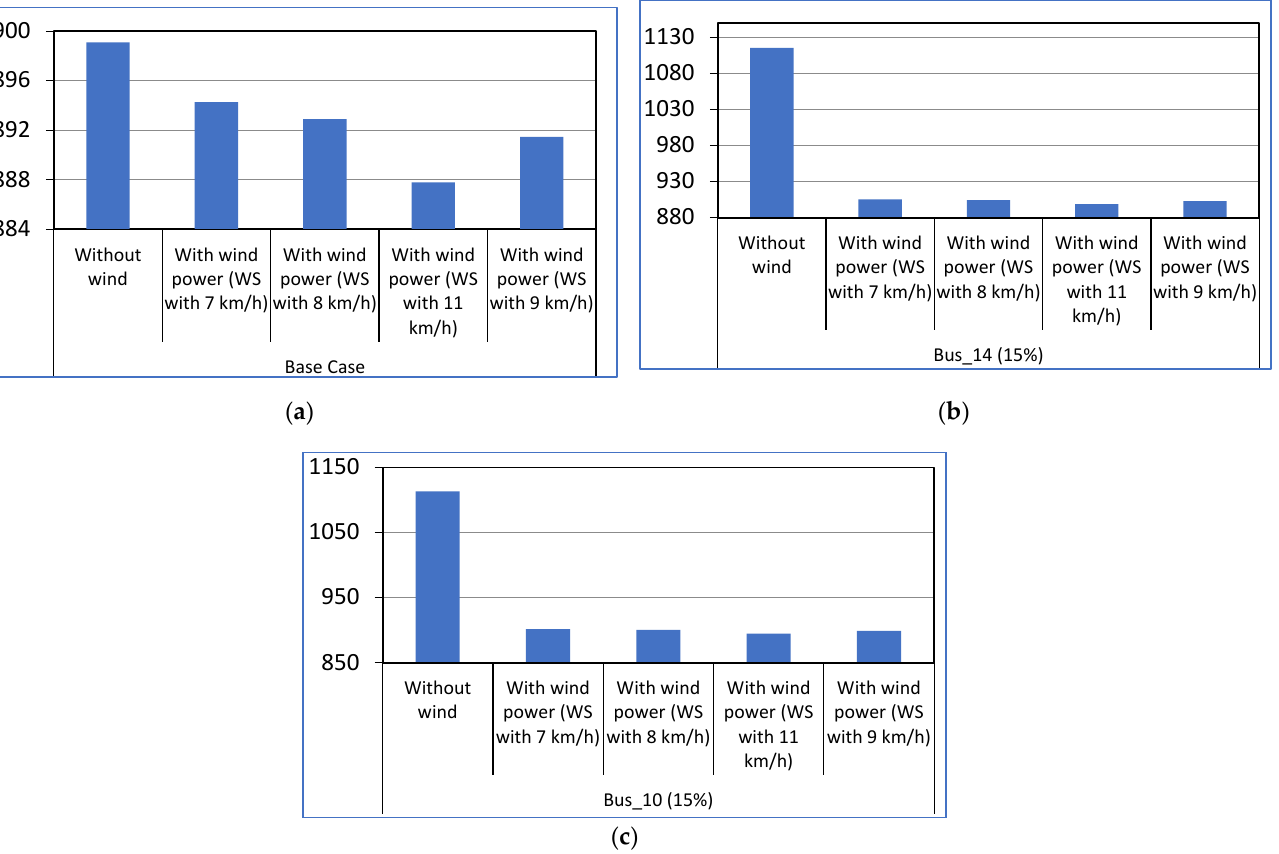
Figure 7. System Risk with Wind Power Integration (Mumbai @ Bus_10 (15%)). VaR based on NP ( a ), CvaR basd on NP ( b ), VaR based on LF ( c ), CvaR based on LF ( d ).